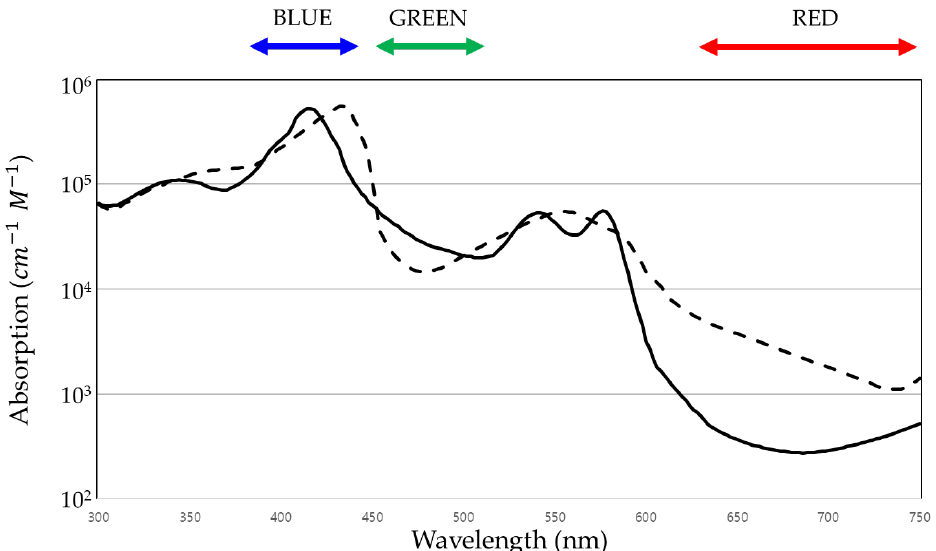
Figure 1. Wavelength-dependent absorption coefficients of oxygenated (solid line) and deoxygenated hemoglobin (dashed line).